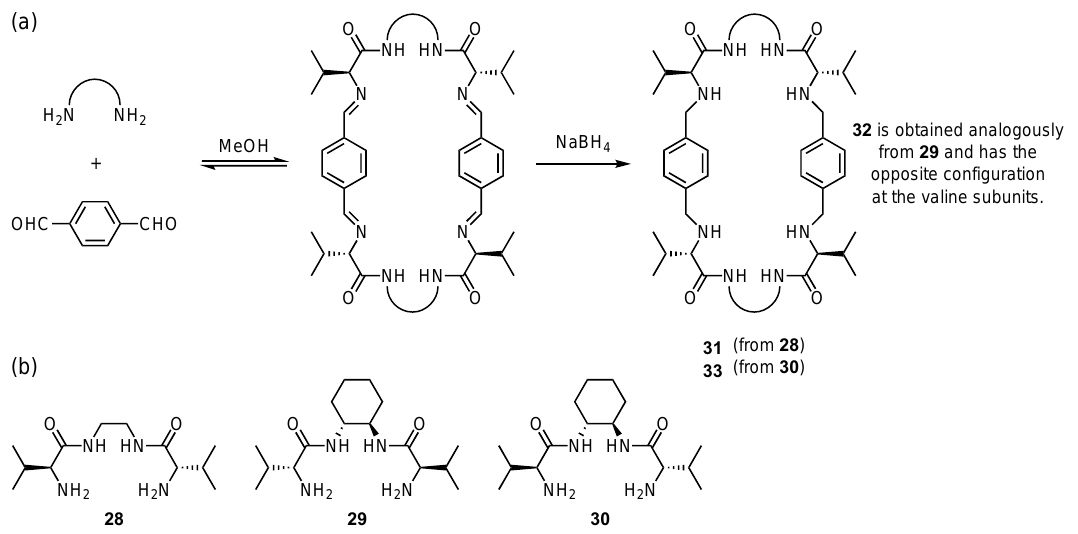
Figure 13. Strategy of the [2 + 2] macrocyclization by reacting diamines with flanking amino acid subunits with terephthalaldehyde via an intermediate tetraimine that is reduced to afford the stable tetraamine product ( a ), and structure of building blocks 28 , 29 , and 30 that afford the respective macrocyclic pseudopeptides 31 , 32 , and 33 ( b ).